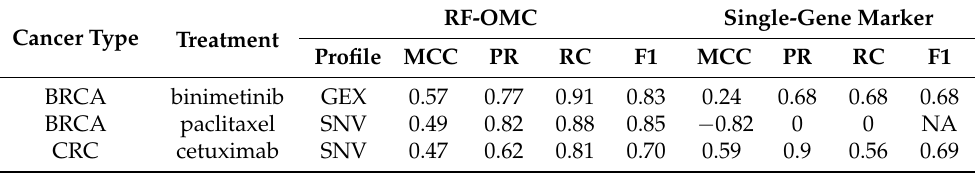
Table 1. Random Forest model with Optimal Model Complexity (OMC) and the corresponding single-gene marker in one replicate for the three best cases, including BRCA—binimetinib, BRCA— paclitaxel and CRC—cetuximab. MCC: Matthews Correlation Coefficient; PR: Precision; RC: Recall; F1: F1